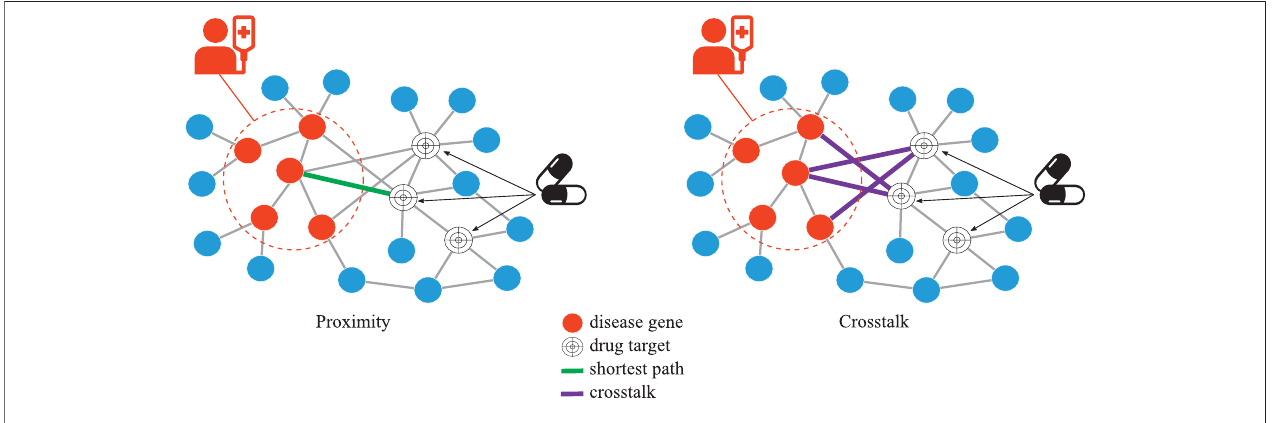
FIGURE 1 | Network-based drug repurposing, proximity vs. crosstalk, for a given disease and drug. In crosstalk, the number of network links between all drug targets and disease genes is used while, in proximity, the length of the single shortest path between any drug target and any closest disease gene is used.